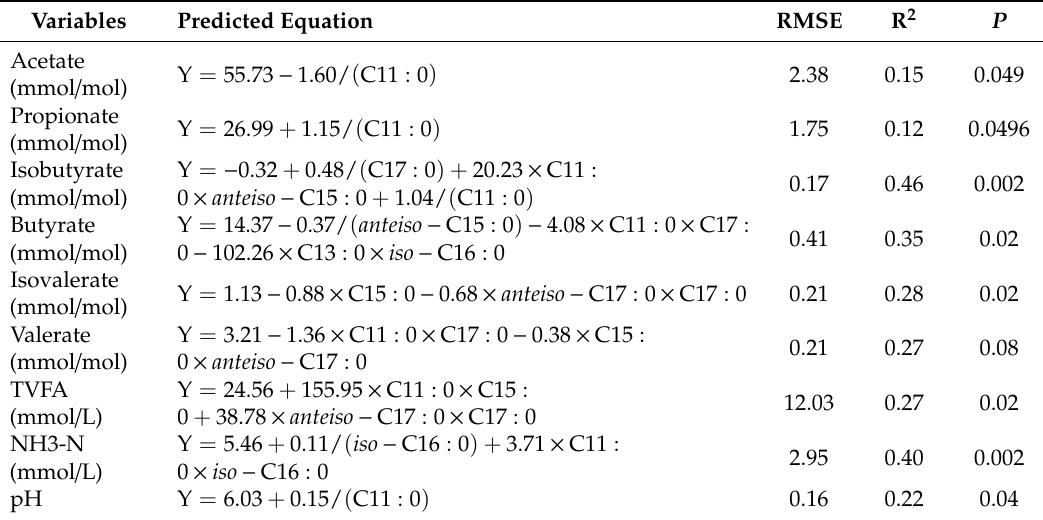
Table 9. Predicted equations of ruminal fermentation parameters from milk OBCFA. Variables